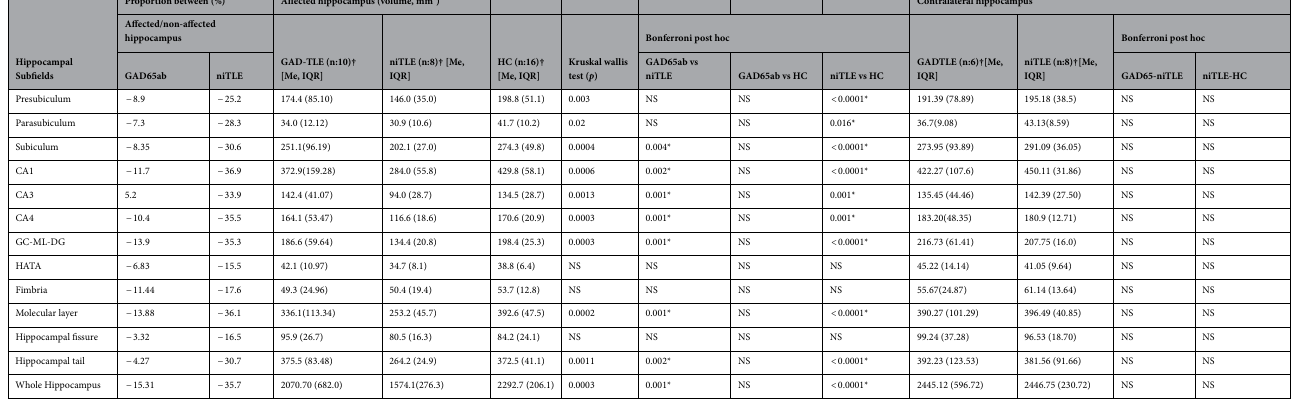
Table 2. Whole and subfield volumes of the affected and contralateral hippocampus of GAD-TLE patients compared with those of niTLE and HC. † n number of hippocampus included in the analysis, CA1-2–3-4